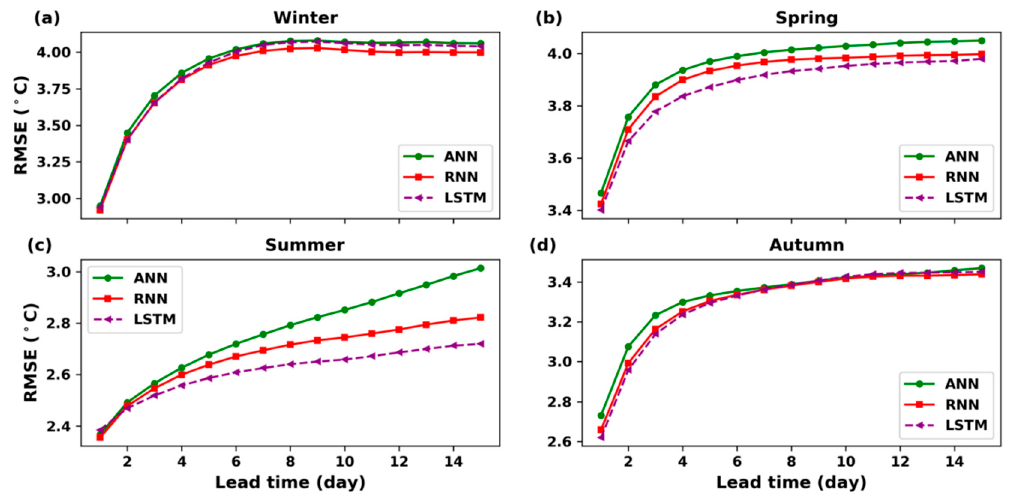
Figure 10. RMSE of 15-day-ahead prediction for each season, ( a ) Winter, ( b ) Spring, ( c ) Summer, ( d ) Autumn.